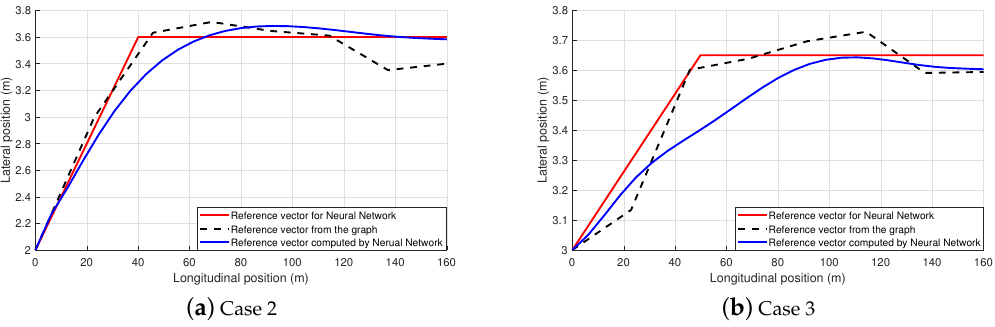
Figure 12. Result of the algorithm in cases 2 and 3.